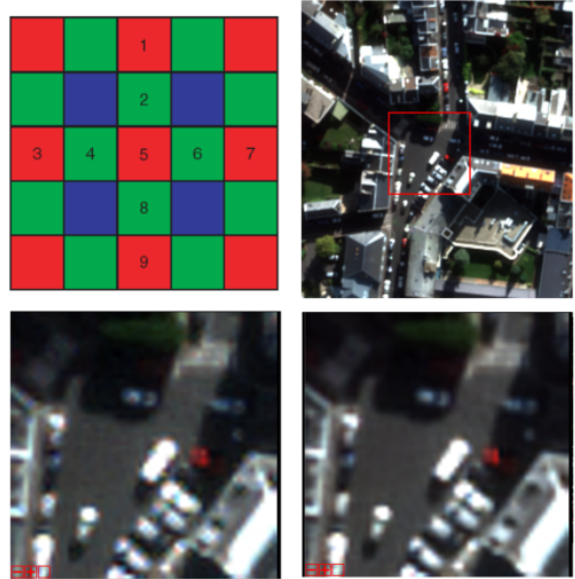
Figure 6. ( Top left ) Bayer matrix with numbering for HA tech- nique. ( Top right ) Input simulated image (Amiens, France) for demosaicing with noise. Image processed using HA before ( bot- tom left ) and after ( bottom right ) our denoising approach.